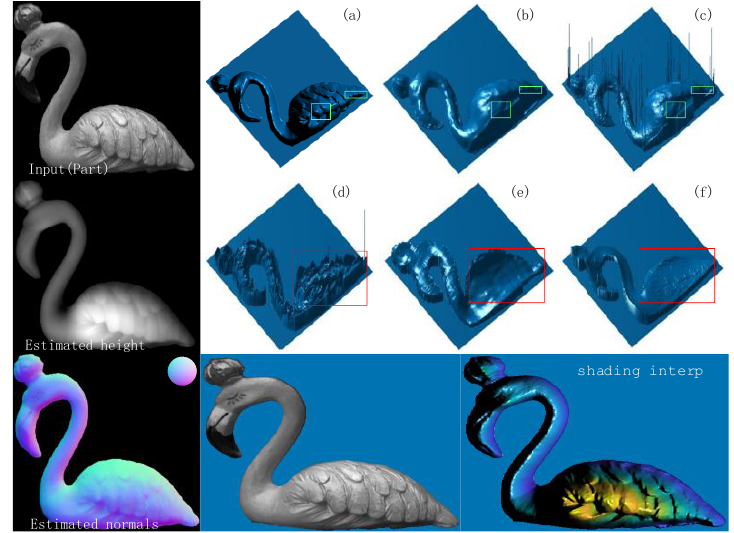
Figure 14. Bird reconstruction results. (a) Ours; (b) Reference [12]; (c) Multiple perspectives; (d) Reference [22]; (e) Reference [23]. (f) FC Algorithm. With the red and green boxes, the contrast between the reconstructed textures can be made.